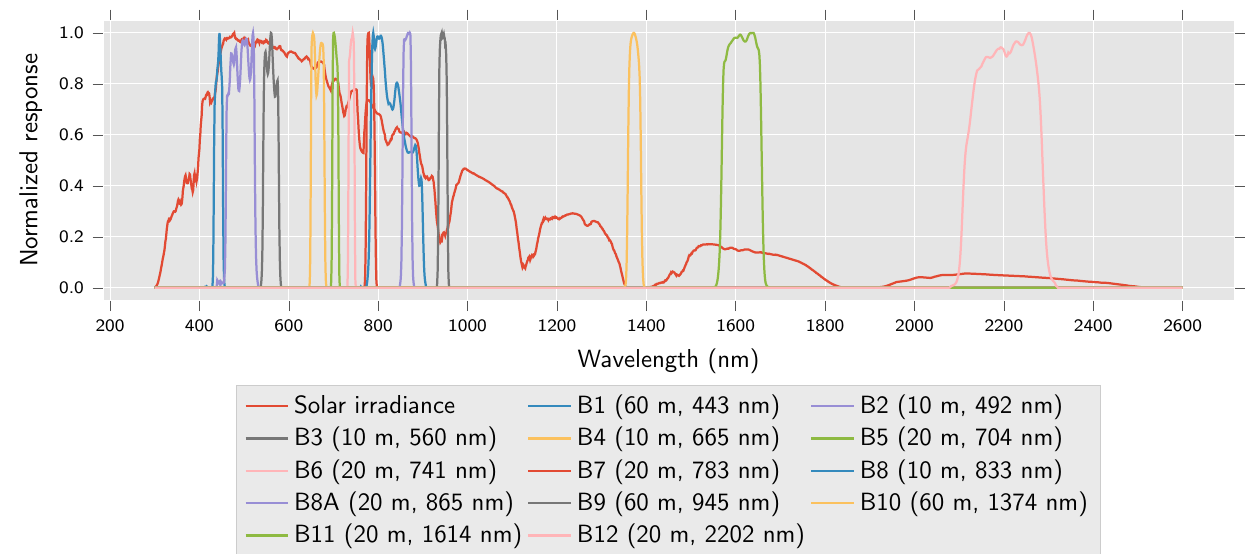
Figure 1. Sentinel-2 spectral response characteristics from [1] alongside earth surface solar irradiance from [3]. Spatial resolution and central spectral wavelength of each band appear in parentheses in the